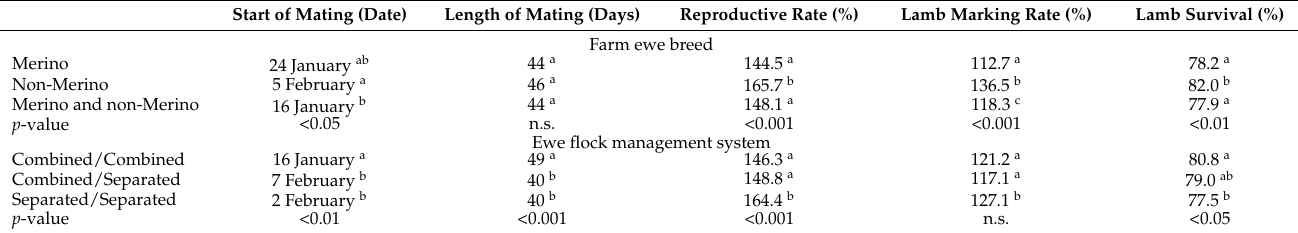
Table 2. Average date at start of mating period, length of mating period, reproductive rate (foetuses per 100 ewes mated; 245 flocks), lamb marking rate (lambs marked per 100 ewes mated; 240 flocks) and lamb survival (lambs marked per 100 foetuses scanned; 227 flocks) for survey participants in 2017 and 2018. The data are presented for farms with different ewe breeds (Merino, non-Merino or both), and for flocks where multiple bearing ewes were always combined together (‘Combined/Combined’), flocks where multiple bearing ewes were combined from farms that separated some triplet-bearing ewes from twin-bearing ewes in either 2017 or 2018 (‘Combined/Separated’), and flocks were twin- and triplet-bearing ewes were always separated